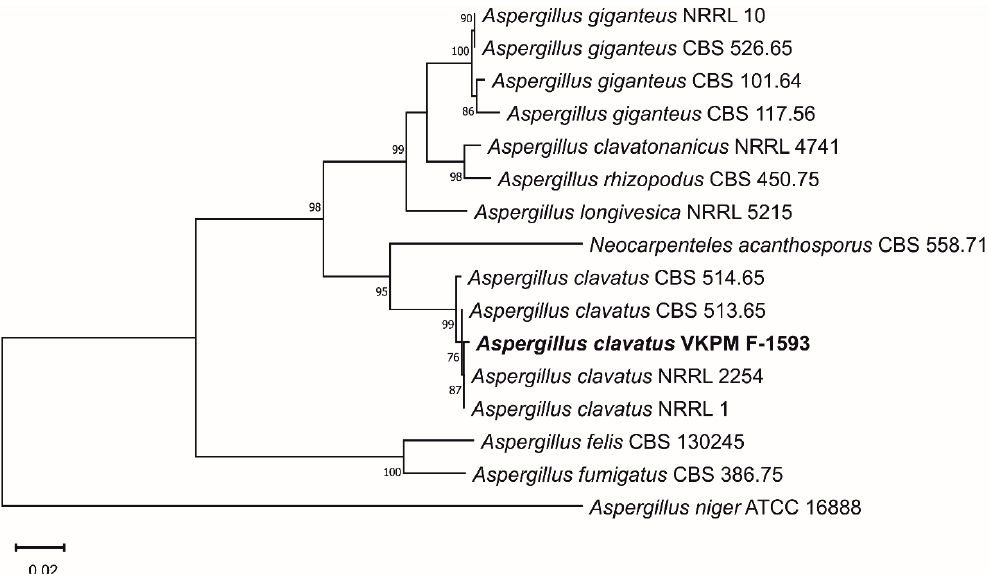
Figure 3. Phylogenetic dendrogram based on concatenated sequences of the benA and D1/D2 domain of the large subunit (26S) ribosomal RNA genes. DNA sequences of the A. clavatus VKPM F-1593 strain were compared with the strains belonging to Aspergillus section Clavati [38] and other closely related species. The phylogenetic tree was constructed by means of the maximum likelihood method with MEGA X ver. 10.0.5. Bootstrap analysis was performed using 1000 replicates. Substitutions per nucleotide position: 0.02. Only values above 70% are indicated.